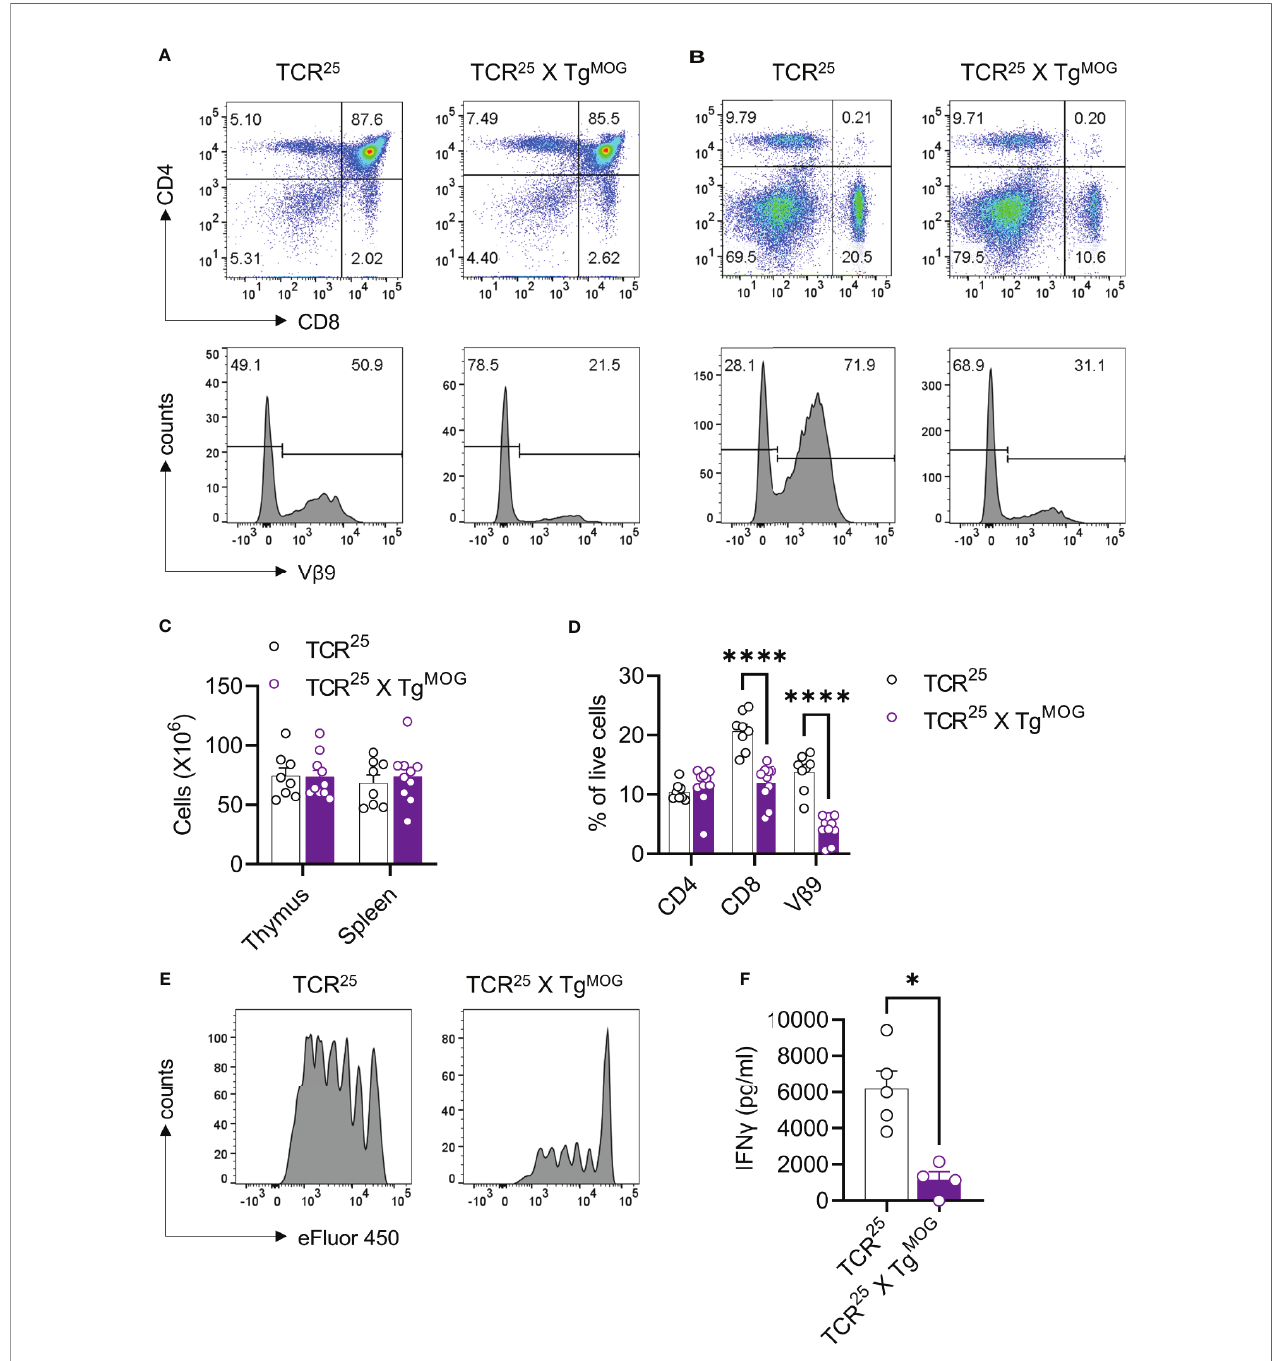
FIGURE 4 | Decreased MOG speci fi c CD8 + T cells in TCR 25 X Tg MOG mice. (A, B) , Flow cytometry analysis of thymus (A) and spleen (B) from TCR 25 and TCR 25 X Tg MOG mice. The expression pattern of CD4 and CD8 is shown (upper panel). Lower panel histograms show transgenic V b 9 + TCR on gated CD8 single-positive cells. Representative data from more than three independent experiments is shown. (C) , Absolute numbers of immune cells from thymus and spleen. The combined data from two independent experiments is shown. Each circle represents an individual mouse. n = 8 – 10 per group. (D) , Frequencies of CD4 + , CD8 +, and V b 9 + T cell populations in the spleen of TCR 25 and TCR 25 X Tg MOG mice. The combined data from two independent experiments is shown. Each circle represents an individual mouse. n = 8 – 10 per group ****P < 0.0001 (Two-way ANOVA). (E) , Proliferation of CD8 + T cells from TCR 25 or TCR 25 X Tg MOG mice in response to MOG 206-214 (2 µg/ml). Histograms of cell proliferation dye e450 fl uorescence on the gated CD8 + T cells are shown. Representative data from 2 experiments are shown. (F) IFN g secretion by splenocytes in response to MOG 206-214 (20 µg/ml). Each circle represents an individual mouse. n = 4 – 5 per group *P = 0.0159 (Mann-Whitney ’ s U-test,